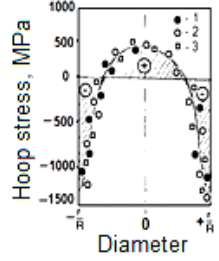
Fig. 1. Residual hoop stress distribution in cylindrical